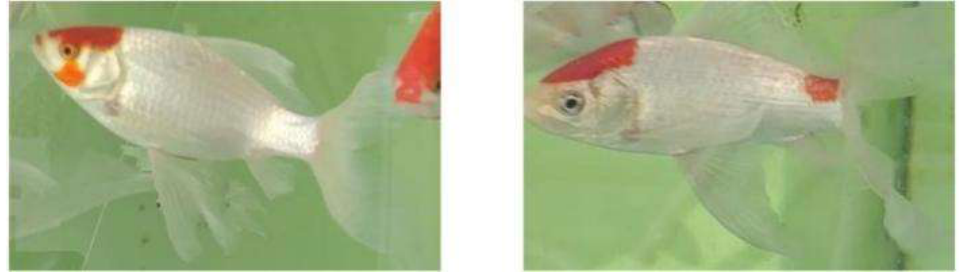
Figure 12. The fish with similar body features and distinct edge point features.